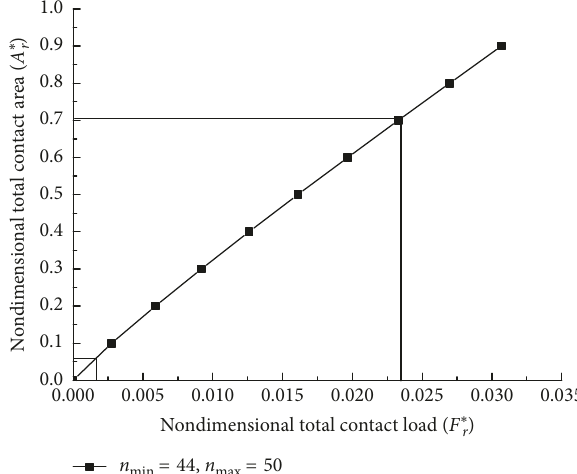
Figure 9: The relationship between dimensionless total real contact area and the dimensionless total contact loading for 20 ≤ n ≤